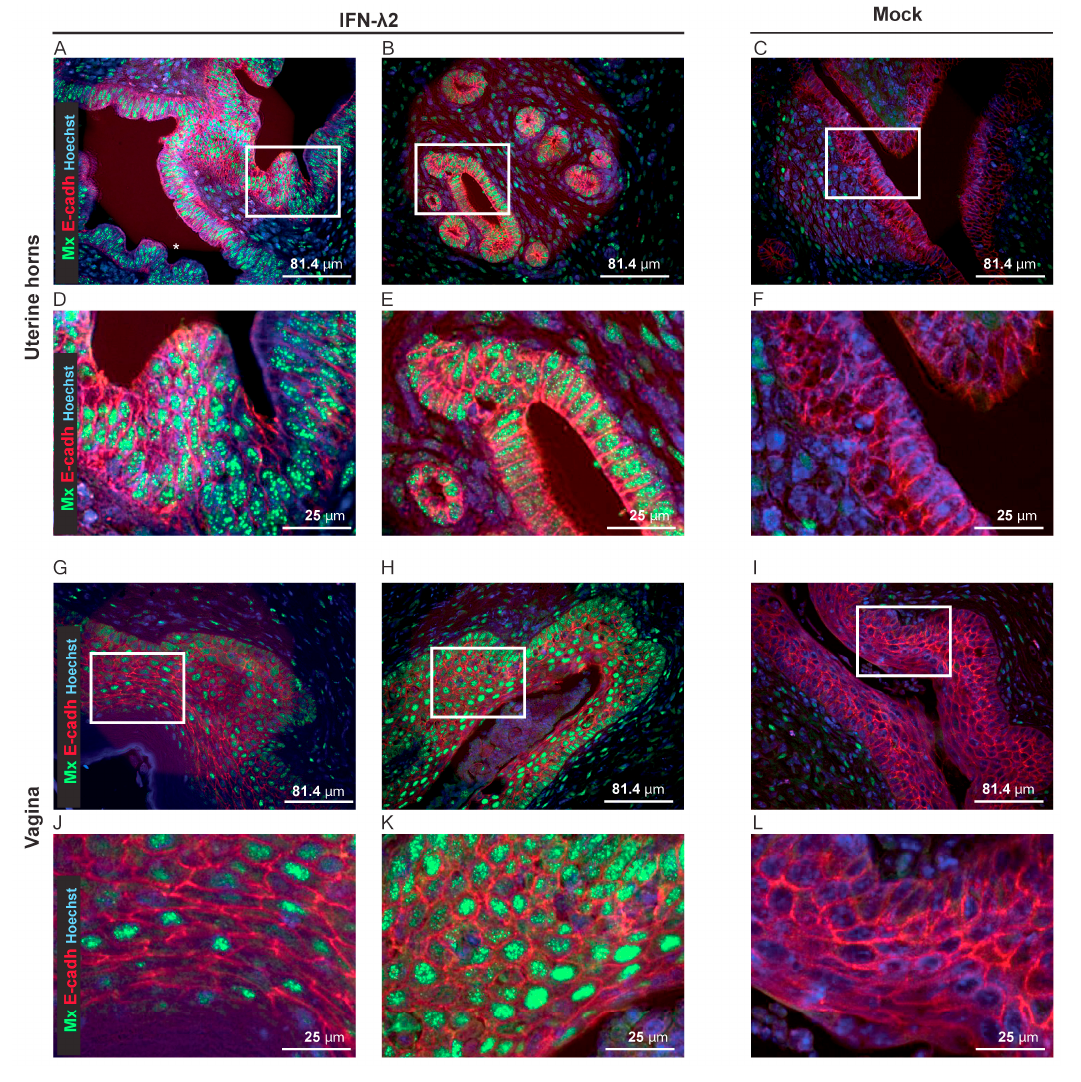
Figure 7. IFN- λ -responsive cells in the genital tract. ( A – L ) Representative sections of the uterine horns and vaginas showing Mx1 expression (green) and E-cadherin+ epithelial cells (E-cadh, red) seven days after electroinjection of B6.A2G-Mx1-IFNAR1 –/– female mice with an empty plasmid (Mock, n = 4) or a plasmid expressing IFN- λ 2 ( n = 4). ( A – F ) Representative sections of the uterine horns revealing extensive Mx1 expression in the E-cadherin positive cells of two IFN- λ -treated ( A,B ) compared to the mock-treated ( C ) mice. ( D – F ) Images zoomed-in from the upper panel (white rectangle). ( G – L ) Representative sections of the vaginal epithelium revealing partial ( G – J ) versus extensive ( H – K ) Mx1 expression in the E-cadherin positive cells of two IFN- λ -treated mice and little Mx1 expression in the E-cadherin positive cells of mock-treated mice ( I – L ). ( J – L ) Images zoomed-in from the upper panel (white rectangle).